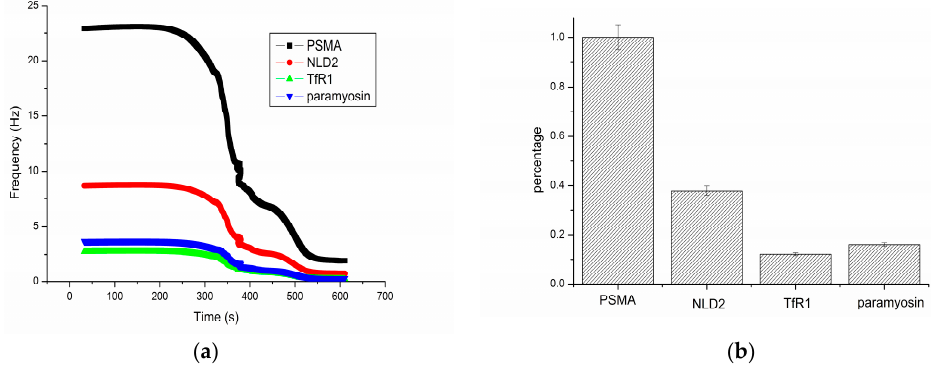
Figure 4. ( a ) Frequency shifts of different proteins; and ( b ) selectivity of the PSMA-MIP based sensor.